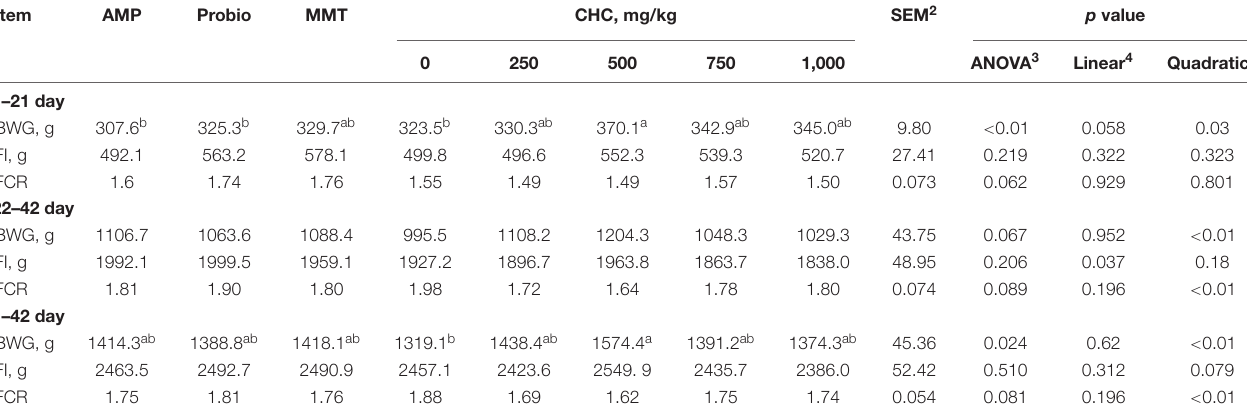
TABLE 2 | Effects of CHC on the growth performance of broilers ( n = 6) 1